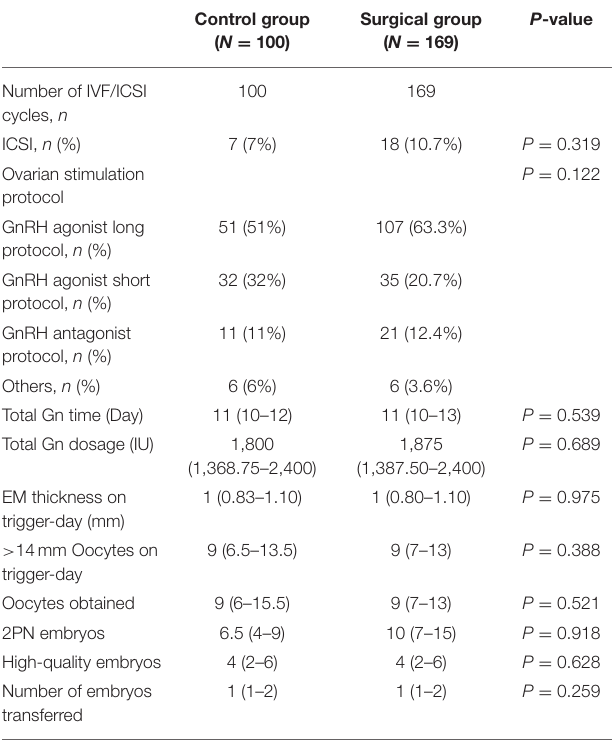
TABLE 2 | Characteristics of IVF-ICSI stimulation cycles and embryological results. TABLE 3 | Reproductive outcomes calculated per fresh ET cycle.